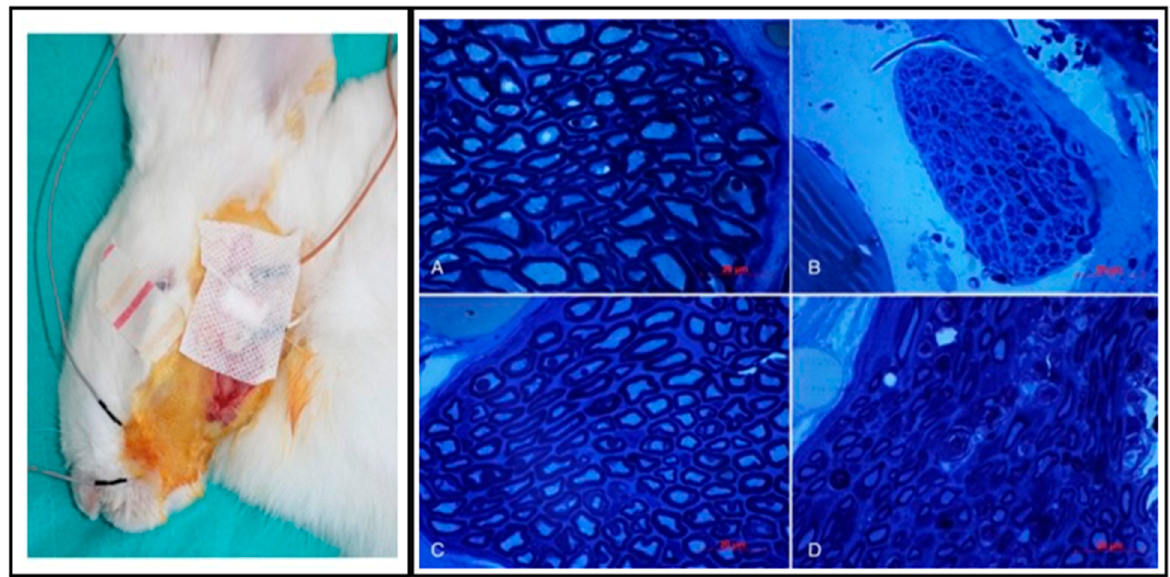
Figure 8. Electrophysiological and histological evaluation of the rabbit facial nerve in the control group ( A ), degenerated neural tissue ( B ), thymoquinone-treated group ( C ), and methylprednisolone-treated group ( D ) (Reprinted/adapted with permission from Ref. [183] . 2016, Elsevier).